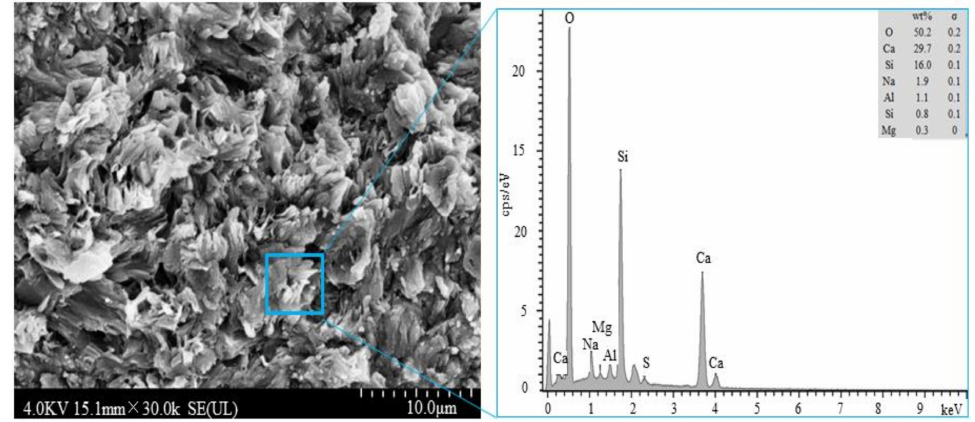
Figure 12. Scanning electron microscope energy dispersive spectroscopy (SEM–EDS) of the silica sample at 60